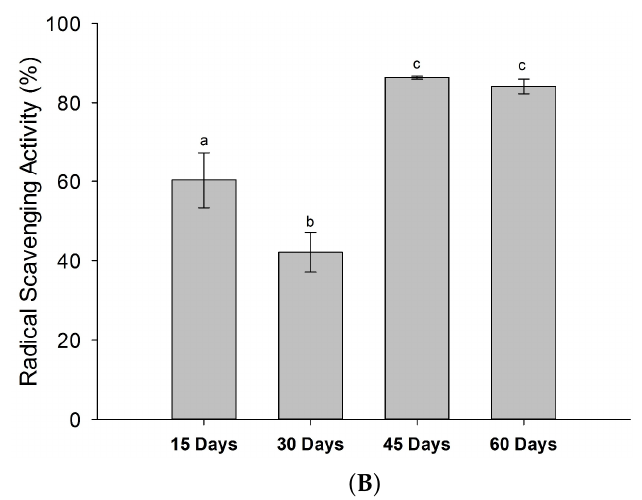
Figure 5. ( A ) Total Phenolic Contents (mg/100 g); ( B ) Radical Scavenging Activity (%). Changes in the total phenolic contents and radical scavenging activity of the apricot leaves during maturation. Different letters (a–e) in each column represent significant differences at p < 0.05 (Tukey’s